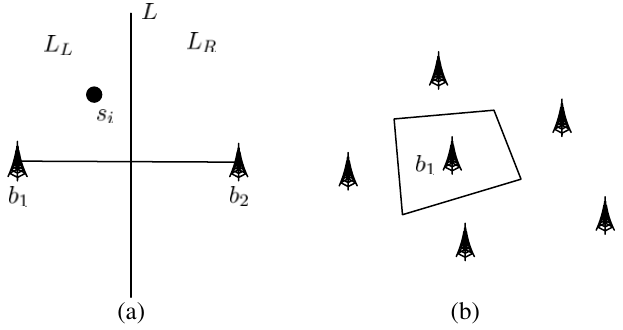
Figure 3. The division by the Varonoi graphic algorithm ( a ) b 1 and b 2 are two base stations in the network topology ( b ) the Varonoi polygon of b 1